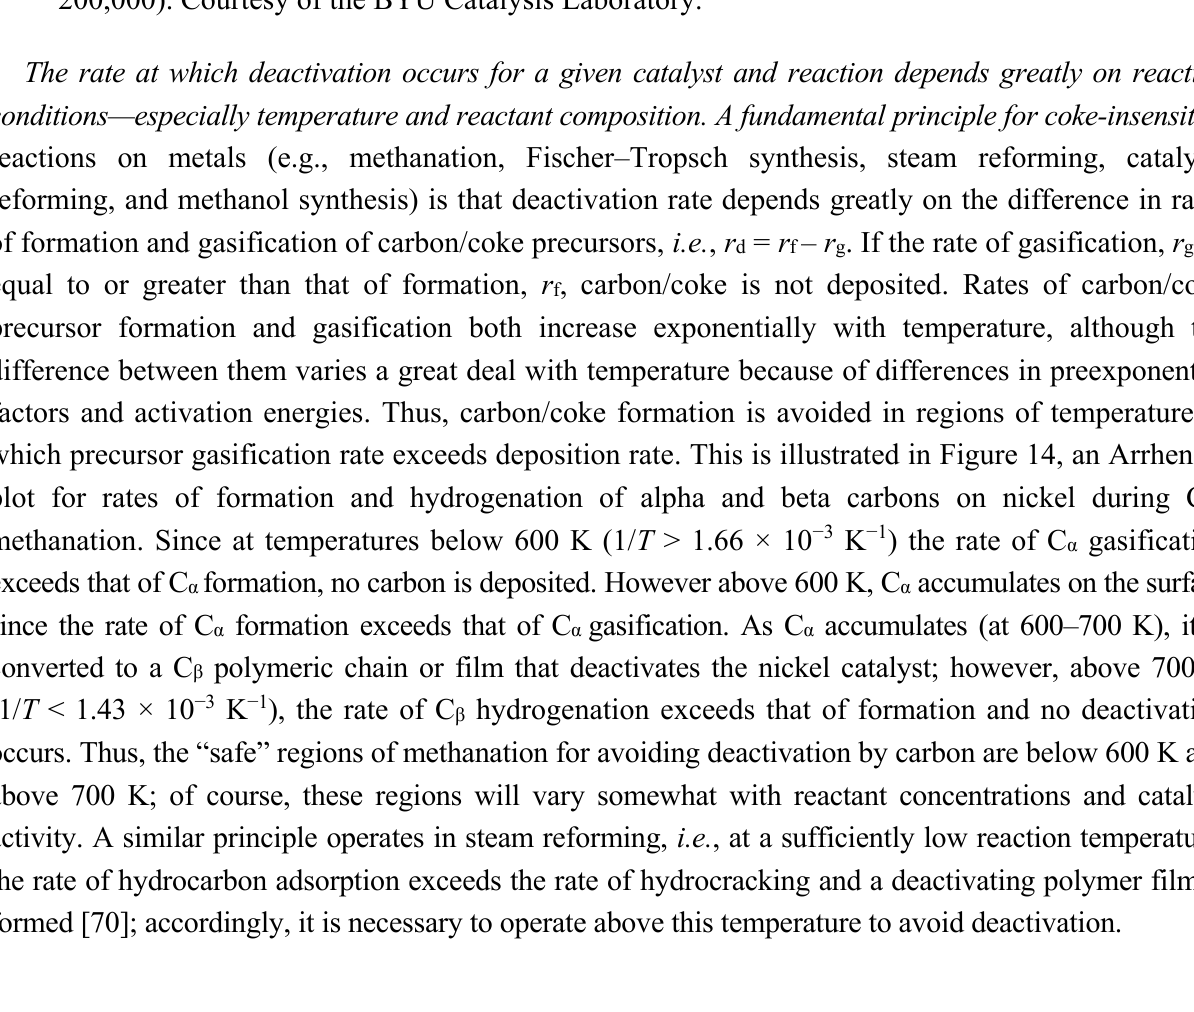
Figure 13. Electron micrograph of 14% Ni/Al 2 O 3 having undergone extensive carbon deposition during CO disproportionation at 673 K, P CO = 4.55 kPa (magnification of 200,000). Courtesy of the BYU Catalysis